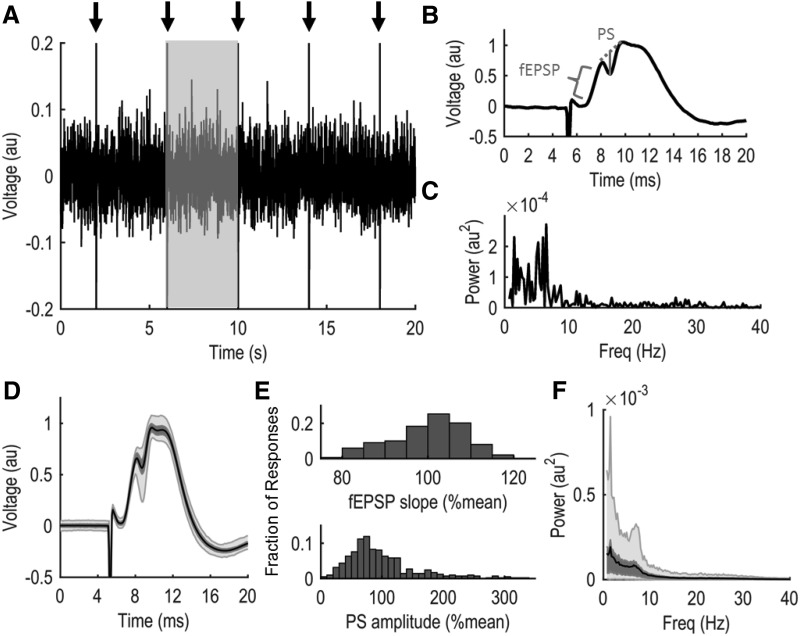

Extensive variability of evoked response magnitude and spontaneous EEG power during a 28-min continuous recording session. A, Twenty seconds of raw EEG data from an individual rat. Arrows denote electrical stimulation to produce an evoked response. B, A typical evoked response. To quantify the evoked response, fEPSP slope is calculated within the bracketed region while PS amplitude (solid gray line) is the amplitude from response trough to the tangent line connecting response peaks (dotted line). C, Power spectrum of spontaneous EEG activity from the 4-s shaded region in A. D, Average evoked response from all 420 stimulations during a recording session in a single rat. E, Extensive variability in the evoked response is observed in both the fEPSP slope (top) and PS amplitude (bottom). F, The power spectrum of SBA averaged across all 4-s epochs of the recording session. Power spectra were calculated from 0.5 to 100 Hz but are only depicted to 40 Hz here for enhanced visualization. In D, F, dark shaded regions encompass the middle 50% of all observed values and light shaded regions encompass 95% of all observed values. Similar variability in both evoked responses magnitude and EEG power was observed when the stimulation frequency was 0.10 Hz instead of 0.25 Hz (see Results).